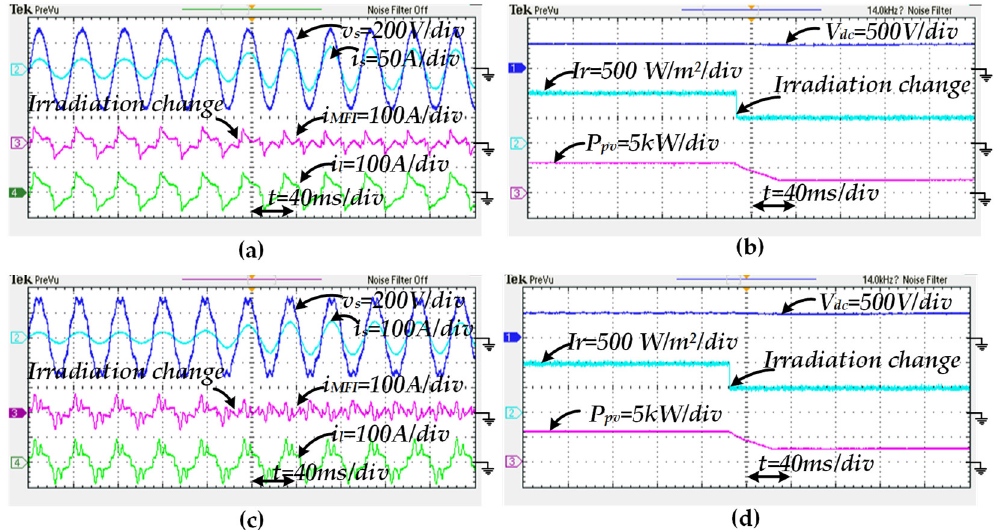
Figure 16. RT SIL test dynamic response at PCC under grid sharing and power conditioning mode during Solar irradiation change ( a ) Ideal Grid Input Voltage, Current, MFI current and load current; ( b ) MFI DC-link voltage, solar Irradiation and PV power under ideal grid; ( c ) Distorted Grid Input Voltage, Current, MFI current and load current; ( d ) MFI DC-link voltage, solar Irradiation and PV power under distorted grid.